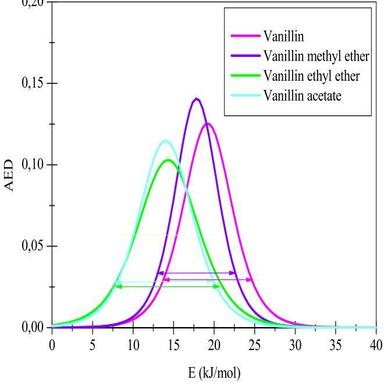
Determination of adsorption energy distributions (AEDs) of the mouse eugenol olfactory receptor mOR-EG activated by vanillin, vanillin methyl ether, vanillin ethyl ether and vanillin acetate odorants using an advanced monolayer adsorption model of ideal gas.